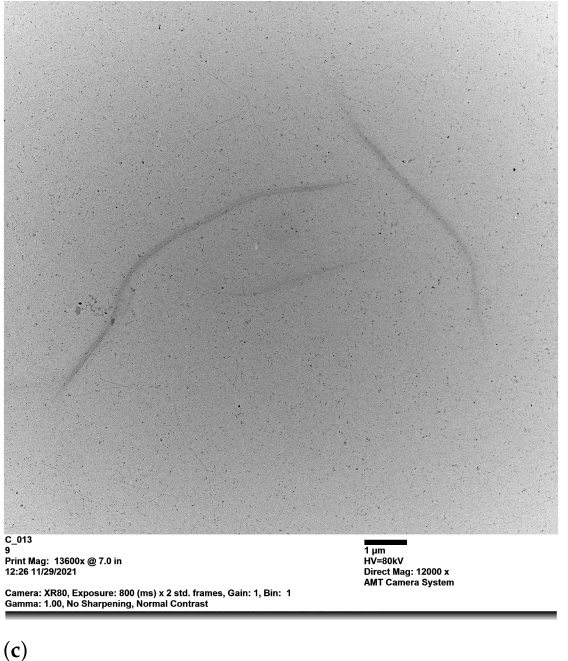
Figure 9. Micrograph Images for buffer #1, #2, and #3. These images were taken from the JEOL 1400 TEM. ( a ) Buffer #1; ( b ) Buffer #2; ( c ) Buffer